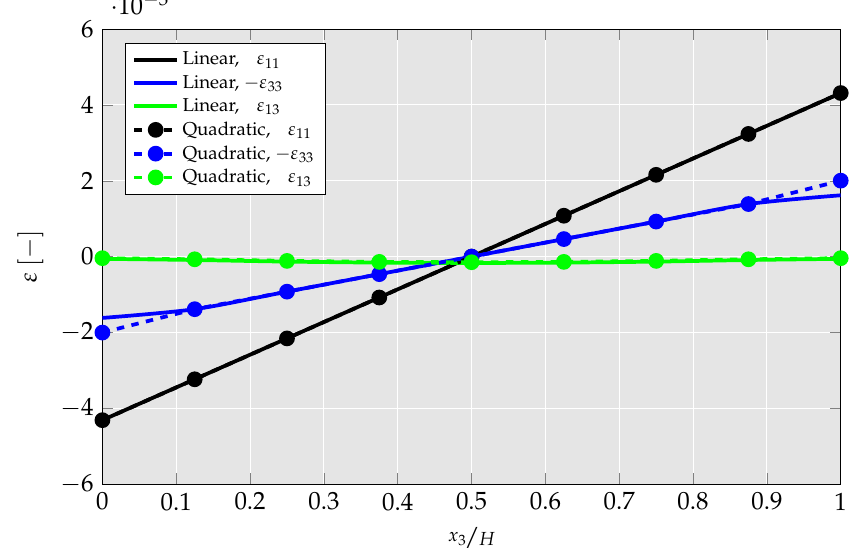
Figure 15. Comparison of the mechanical strain components calculated by using linear and quadratic element through the height of the beam for prescribed mechanical